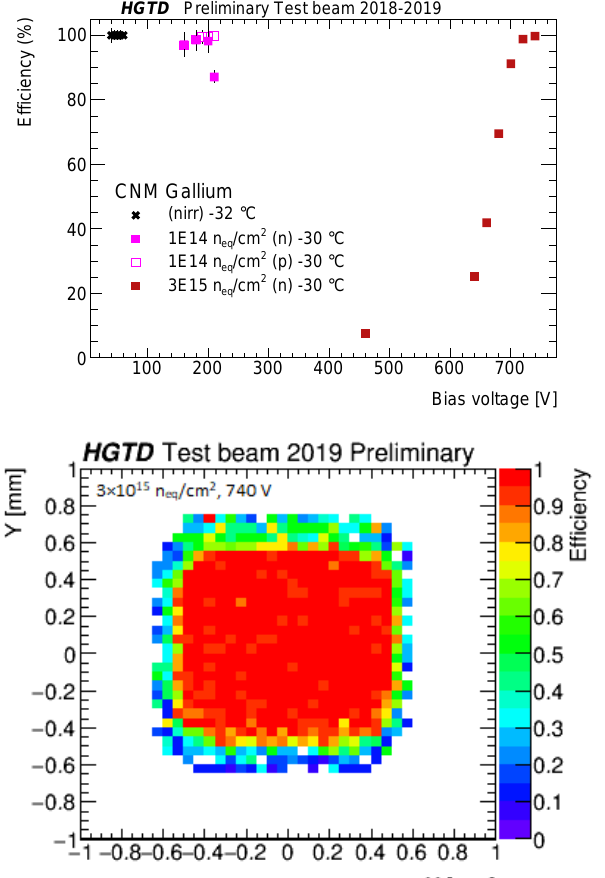
Fig. 10: Efficiency as a function of bias voltage for different single pad sensors built by CNM (top), Signal efficiency in a 1 x 1 mm2 CNM Gallium-doped LGAD irradiated to 3e15 neq/cm2, as a function of the reconstructed position X and Y of particles (in mm) (bottom)